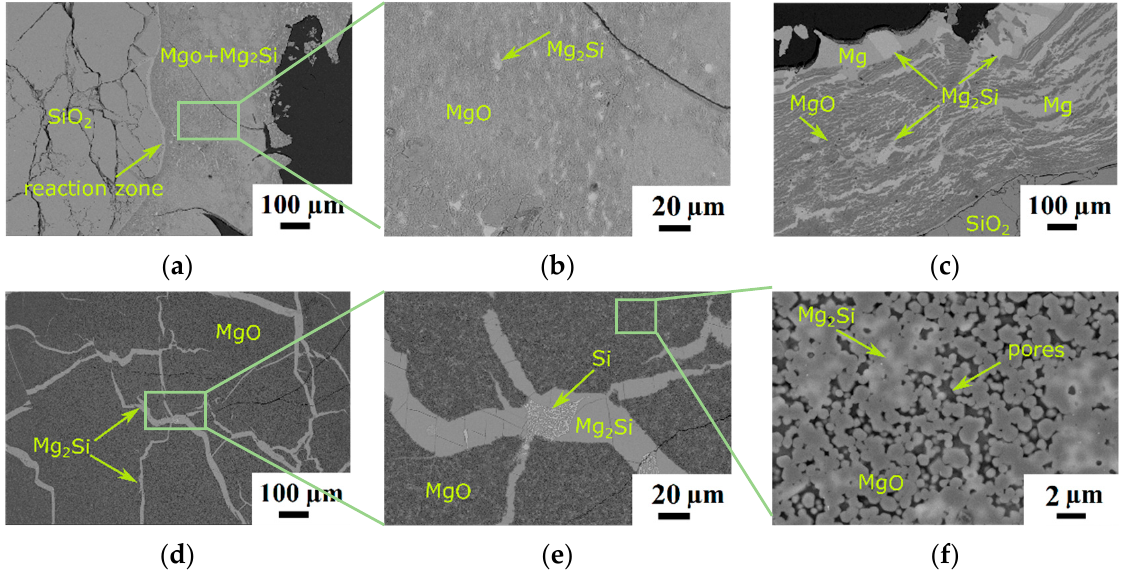
Figure 2. Backscattered electron images of samples at a Mg/SiO 2 mole ratio of 4 and different temperatures: ( a ) 1073 K and 120 min; ( b ) higher magnification of the area shown in the rectangle in Figure 2a; ( c ) 1173 K and 20 min; ( d ) 1273 K and 20 min; ( e ) higher magnification of the area shown